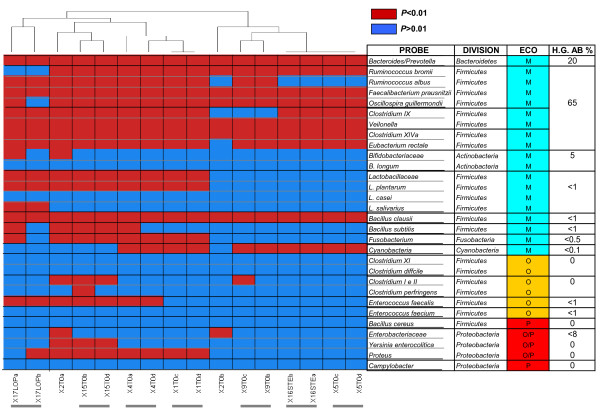
Phylogenetic fingerprints. Cluster analysis of the phylogenetic fingerprint of 16 faecal samples from 8 young adults. Response of each of the HTF-Microbi.Array probes for what concerns presence/absence of the target group is showed: positive response in red (P < 0.01), negative responses in blue (P > 0.01). Gary lines below the samples indicate adjacent replicated LDR of the same sample.